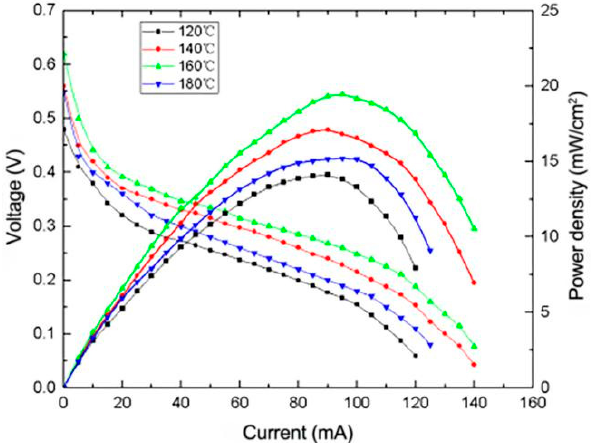
Figure 4. Effect of different heating temperatures on the performance of μ